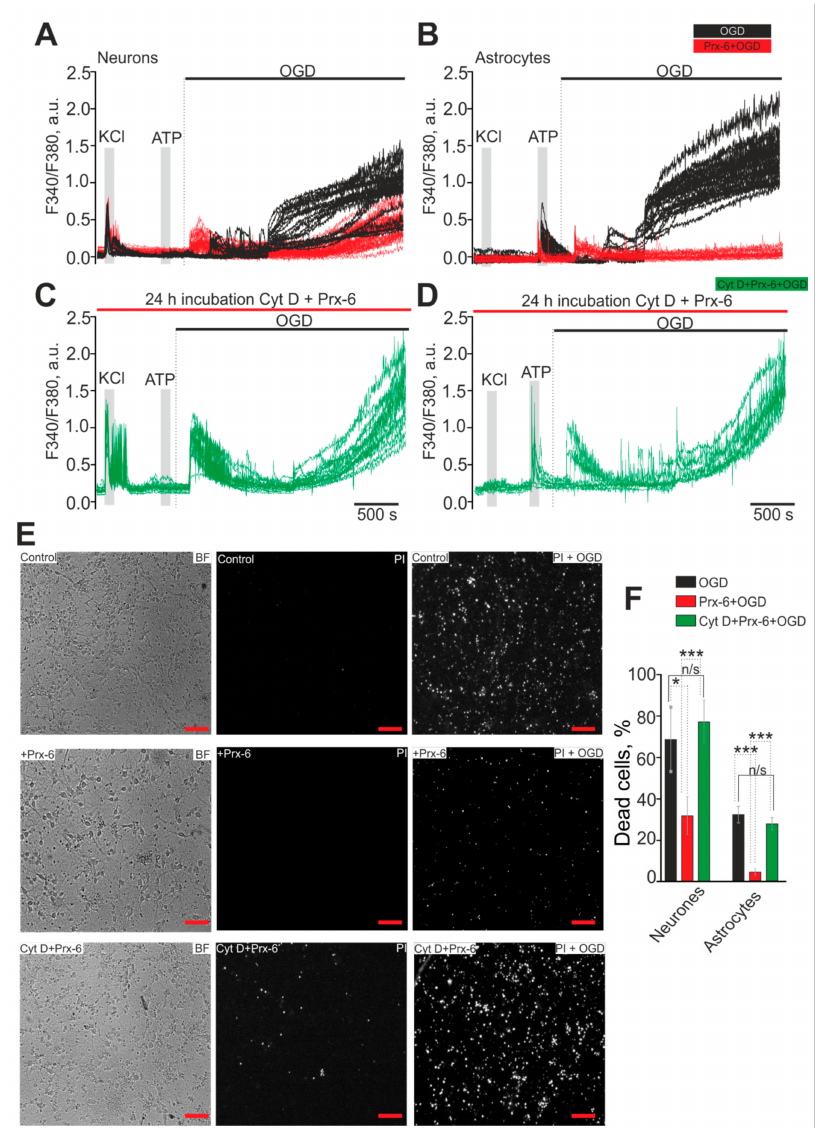
Figure 1. Protective effect of 24-h incubation of hippocampal cells with 100 µ M of the antioxidant enzyme peroxiredoxin-6 (Prx-6) occurs through the mechanism of endocytosis. ( A , B ) Ca 2+ -signals of neurons and astrocytes during a 40-min OGD in control ( A , B , black traces) and after 24-h incubation with Prx-6 (100 µ M) ( A , B , red traces). ( C , D ) Ca 2+ -signals of neurons ( C ) and astrocytes ( D ) during a 40-min OGD after 24-h incubation with 100 µ m Prx-6 and with an endocytosis blocker, Cytochalasin D (Cyt D, 5 µ M). There is an abolition of the inhibitory effect of Prx-6 on the global increase in [Ca 2+ ] i during OGD. Here are presented the Ca 2+ -signals of cells in single experiments obtained using the same cell culture.( E ) Images of hippocampal cell culture in transmitted light (BF), the Propidium Iodide fluorescence detection channel before the experiment (PI) and after 40-min OGD treatment (PI + OGD). The effect of 24-h incubation of cells with Prx-6 and Prx-6 with Cyt D on cell viability after 40 min OGD. The white dots represent the PI-stained nuclei of necrotic cells. ( F ) The average number of PI-stained neurons and astrocytes that died due to OGD-induced necrosis in the absence of Prx-6 (OGD) and after 24-h incubation with 100 µ M of Prx-6 (Prx-6 + OGD) or Prx-6 with 5 µ M Cyt D (Cyt D + Prx-6) (% ± SE). Short-term applications of 35 mM of KCl and 10 µ M of ATP were used to detect neurons and astrocytes, respectively. Statistical significance was assessed using paired t -test. n/s—data not significant ( p > 0.05), * p < 0.05 and *** p < 0.001. Comparison Neurones with Astrocytes significant, *** p -level < 0.001. Scale bar = 30 µ